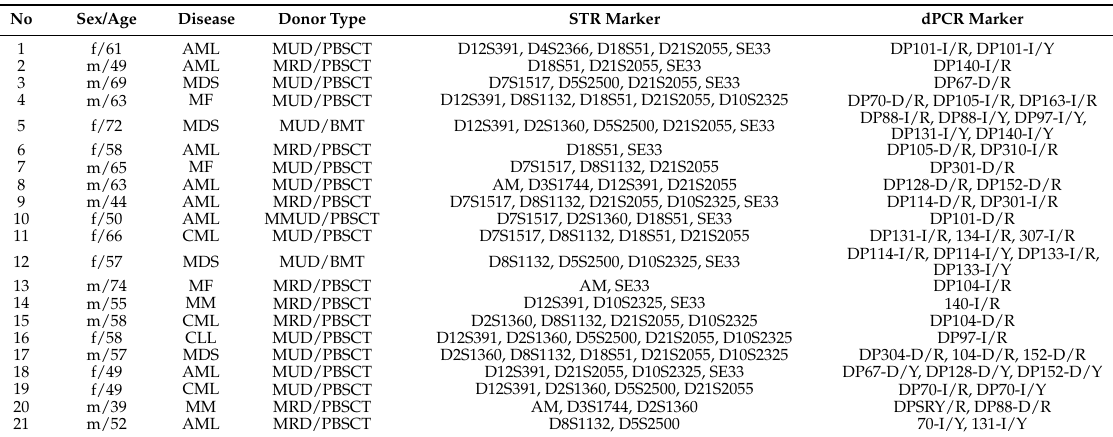
Table 2. Characteristics of patients included in the